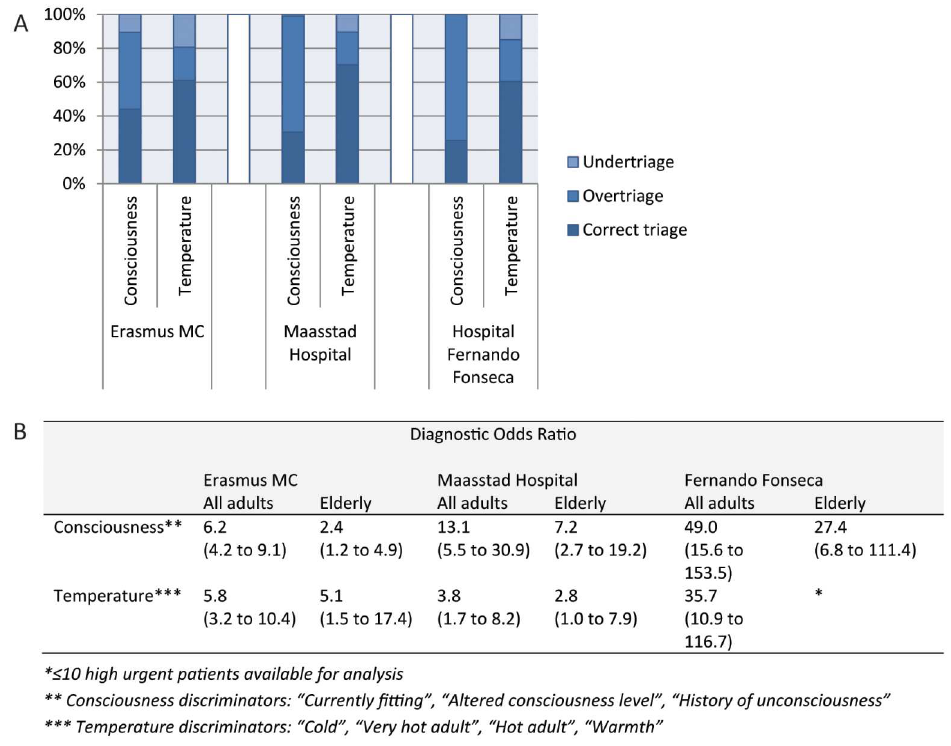
Fig 3. Performance of most commonly used MTS discriminators. A) Percentagesunder-, over-, and correct triage; B) Diagnosticodds